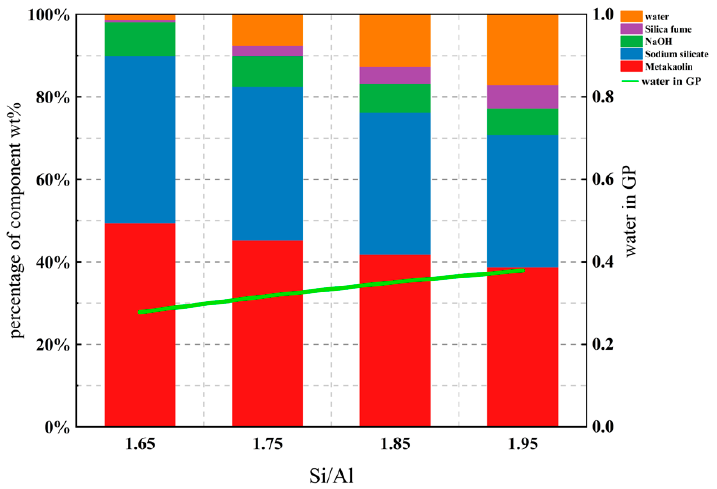
Figure 12. Initial geopolymer constituents and water.